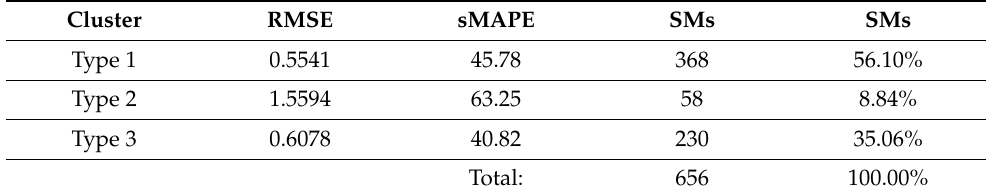
Table 4. RMSE and sMAPE metrics between the time series of each SM and the barycenter of the cluster in which they were